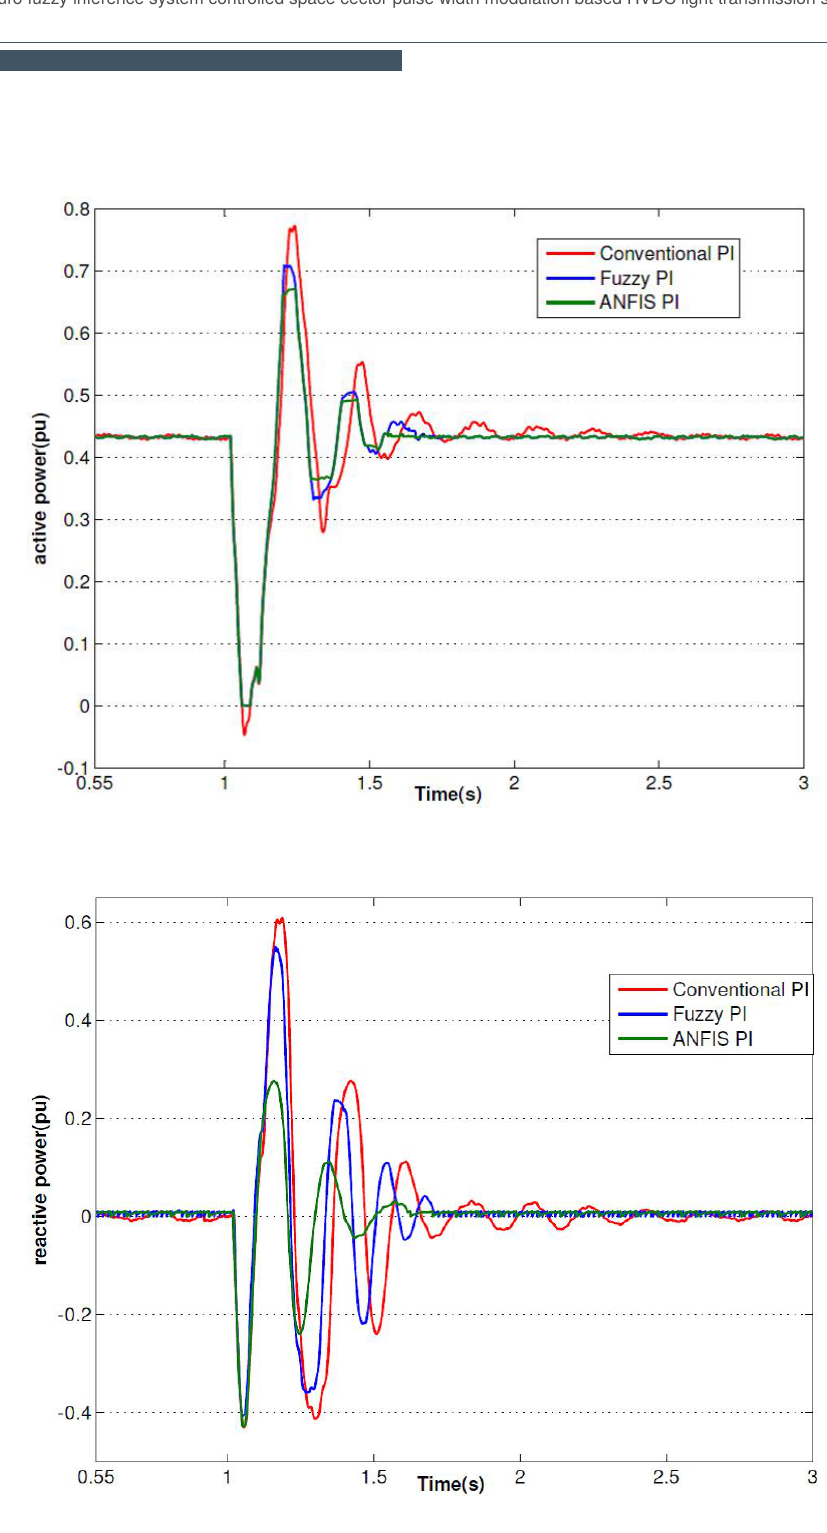
Figure 8. (a) Active power (b) reactive power at rectifier AC bus for a 5 cycle three phase fault on inverter side AC